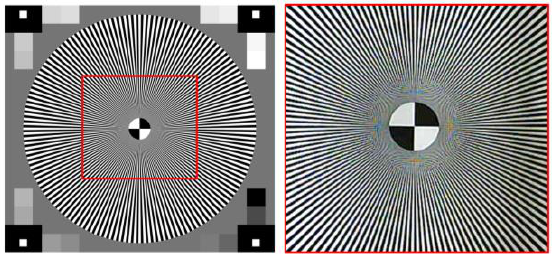
Figure 5. Effect of chromatic aberration on Siemens star